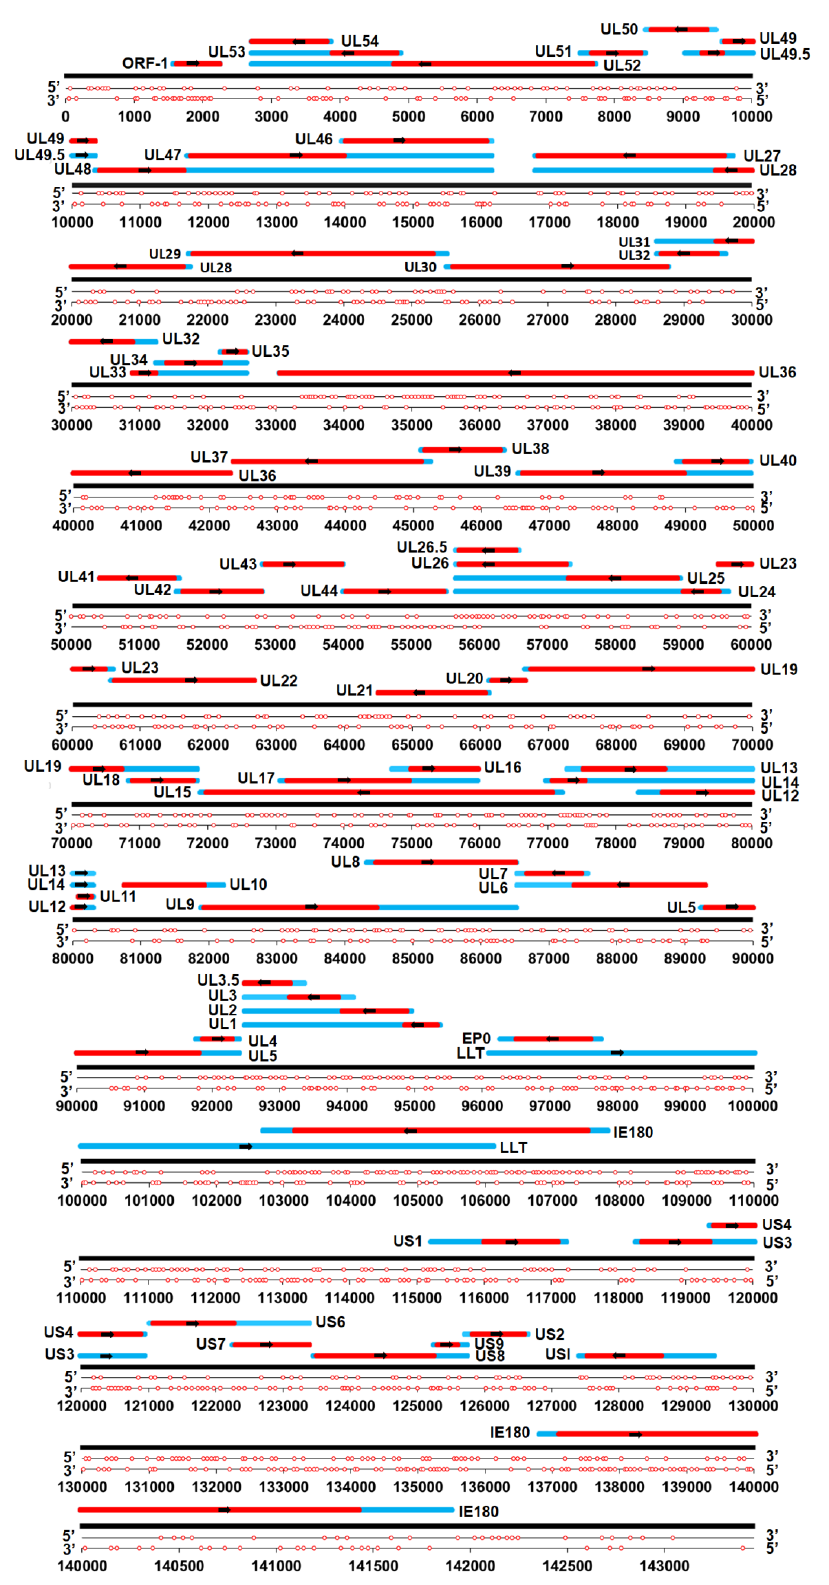
Figure 2. Distribution of G 2 -putative quadruplex sequences (G 2 -PQSs) in the double-strand genome of pseudorabies virus (PRV). One red circle indicates one G 2 -PQS. The red bars indicate the coding sequence (CDS) region. The blue bars indicate the untranslated region.